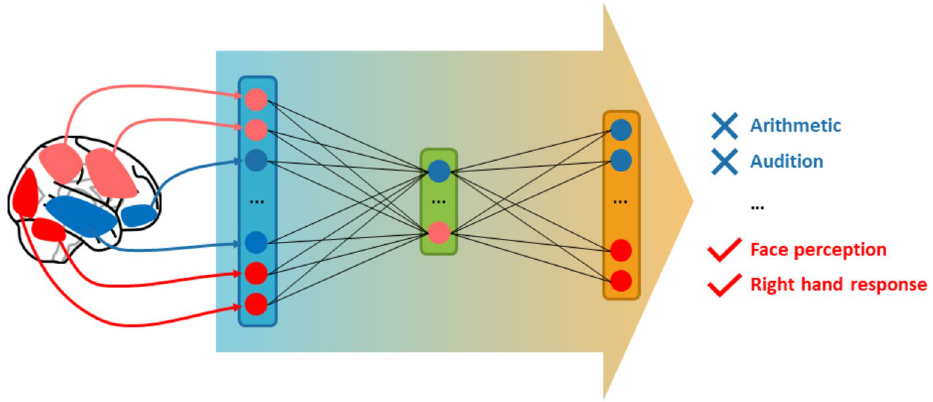
Figure 7. Explored ”NNoD” models. As inputs we used the brain components loadings for the studied contrasts ( in this example ”clicking when viewing a face” vs ”viewing something else” ). The hidden layers were used to increase the expressive power of the model by adding non-linearities and regularize it by controlling their width. We explored networks with 0 to 3 hidden layers. The output layer scores each considered